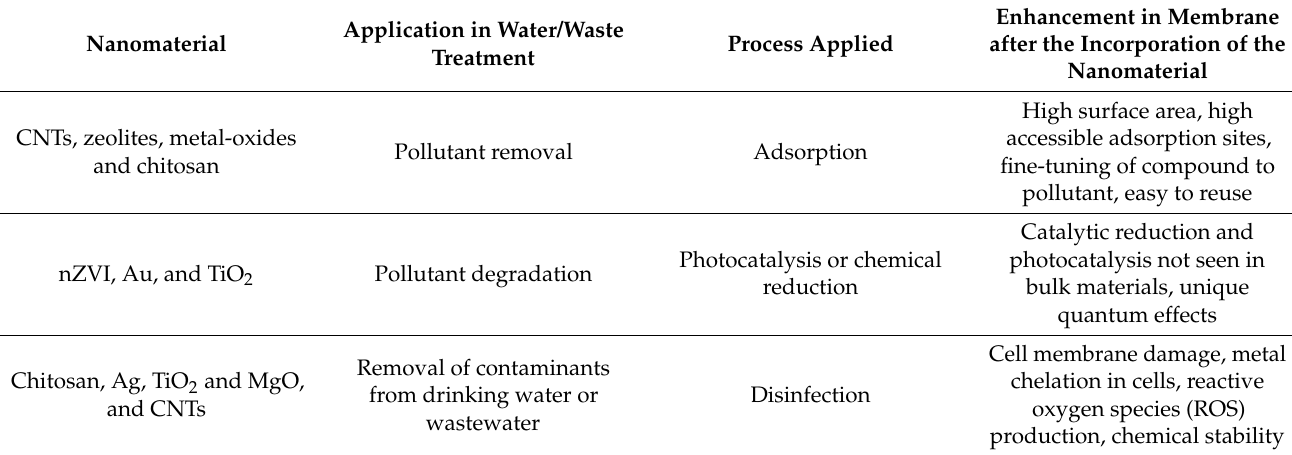
Table 5. Summary of nanomaterials used in membranes for water/wastewater